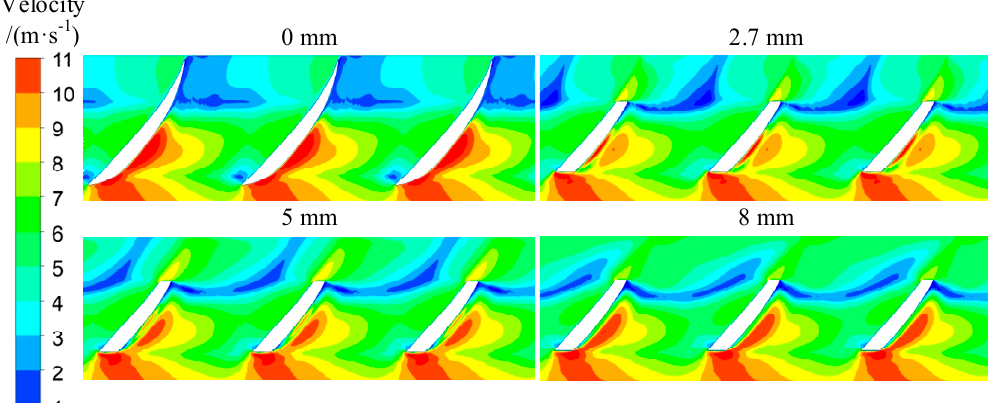
Figure 12. Velocity contour at Span = 0.015 in impeller passage with varying root clearances ( R t = 0 mm, 2.7 mm, 5 mm 8 mm; Q = 1.0 Q des ).